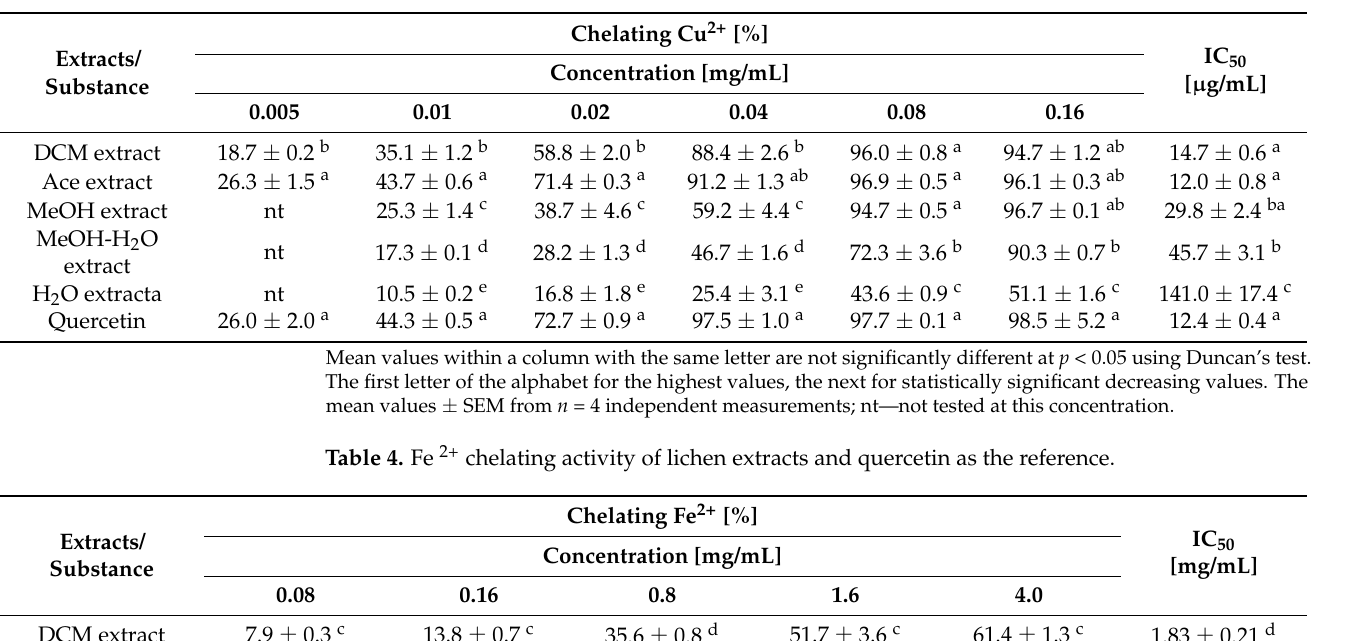
Table 3. Cu 2+ chelating activity of lichen extracts and quercetin as the reference.